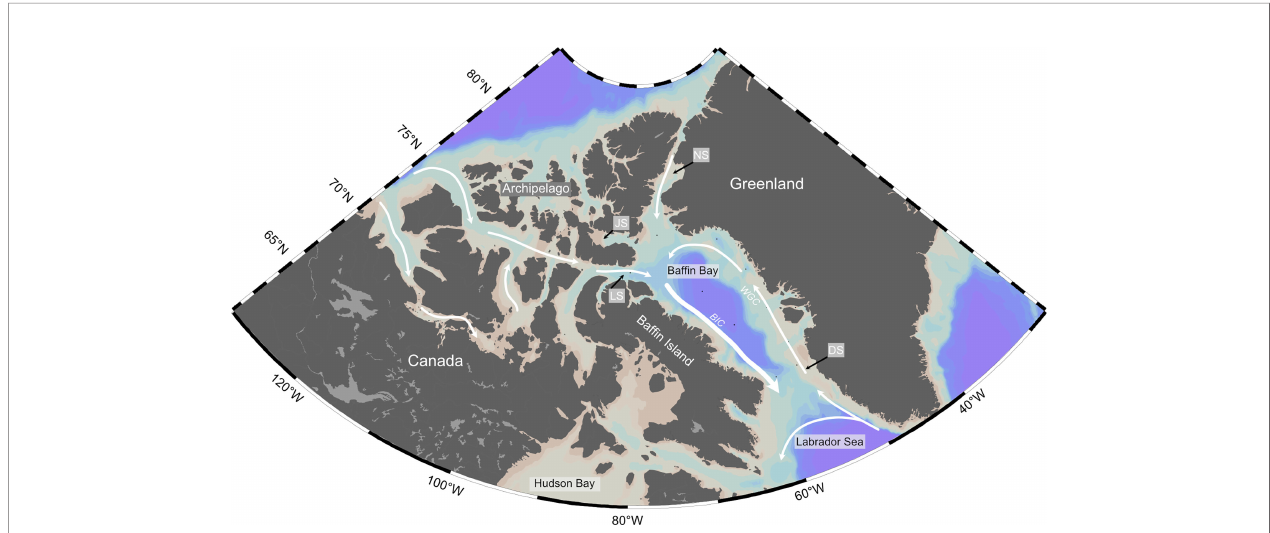
FIGURE 1 | Area Map of Canadian Arctic. White arrows indicate simpli fi ed surface currents and directions. The Western Greenland Current (WGC) and Baf fi n Island Currents (BIC) are speci fi cally indicated. Locations of Baf fi n Bay gateways – Davis Strait (DS), Lancaster Sound (LS), Jones Sound (JS), and Nares Strait (NS) – are indicated with black arrows. Small black dots in Baf fi n Bay represent POM sampling locations from the 2019 research